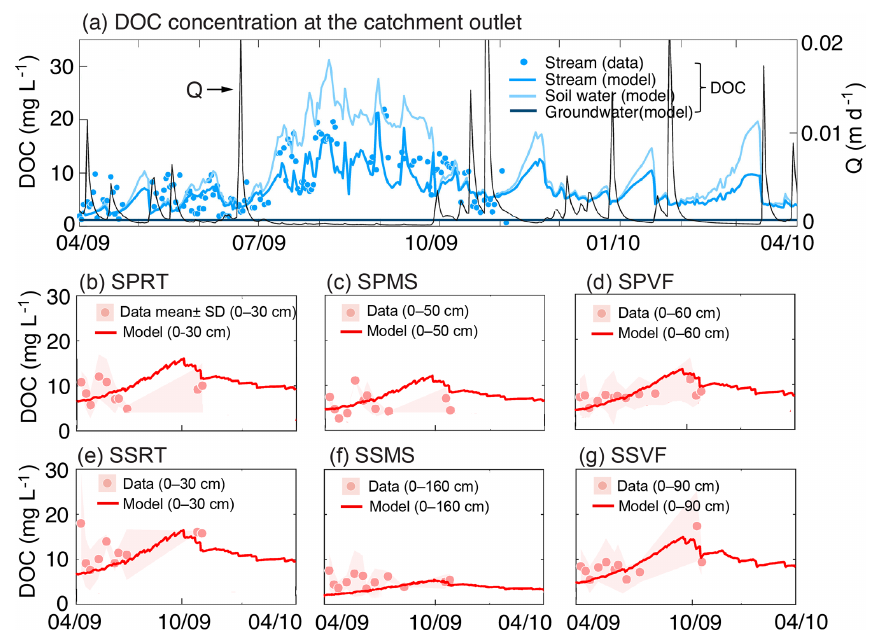
Figure 4. (a) Temporal dynamics of measured and simulated stream DOC concentrations as well as groundwater and soil water DOC. The stream DOC (bright blue line) was from the soil water (light blue line) and groundwater Q G (dark blue line). Under low-discharge conditions (e.g., July–September), Q G contributed a larger proportion of discharge and stream DOC was more similar to groundwater DOC. Under wet conditions, stream DOC resembled soil water DOC from Q L . (b–g) The local soil water DOC concentration for the six sampling locations shown in Fig. 1b, including three planar (panels b – d ) and three swale locations (panels e – g ). The mean ± SD for each location was calculated based on measurements at different depths with 10 or 20cm intervals from the soil surface down to a depth of hand-auger refusal.